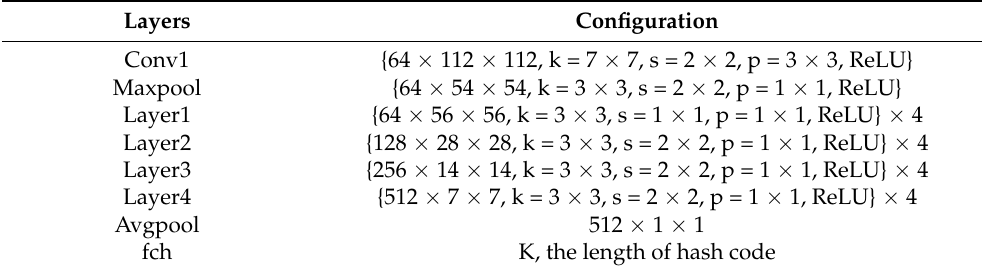
Table 1. Configuration of each layer in DHIDA method.